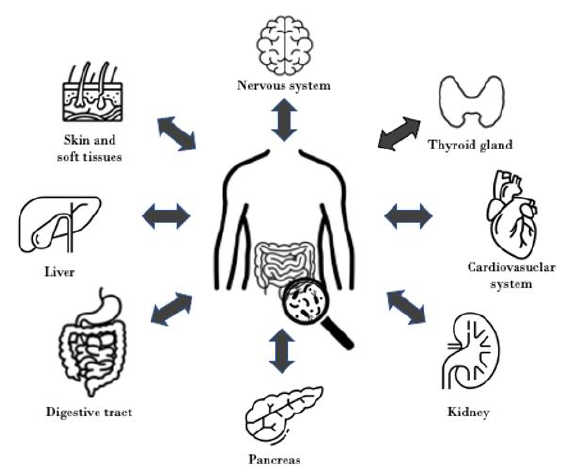
Figure 2. Bidirectional relationships between altered intestinal microbiota and different regions of the human body.